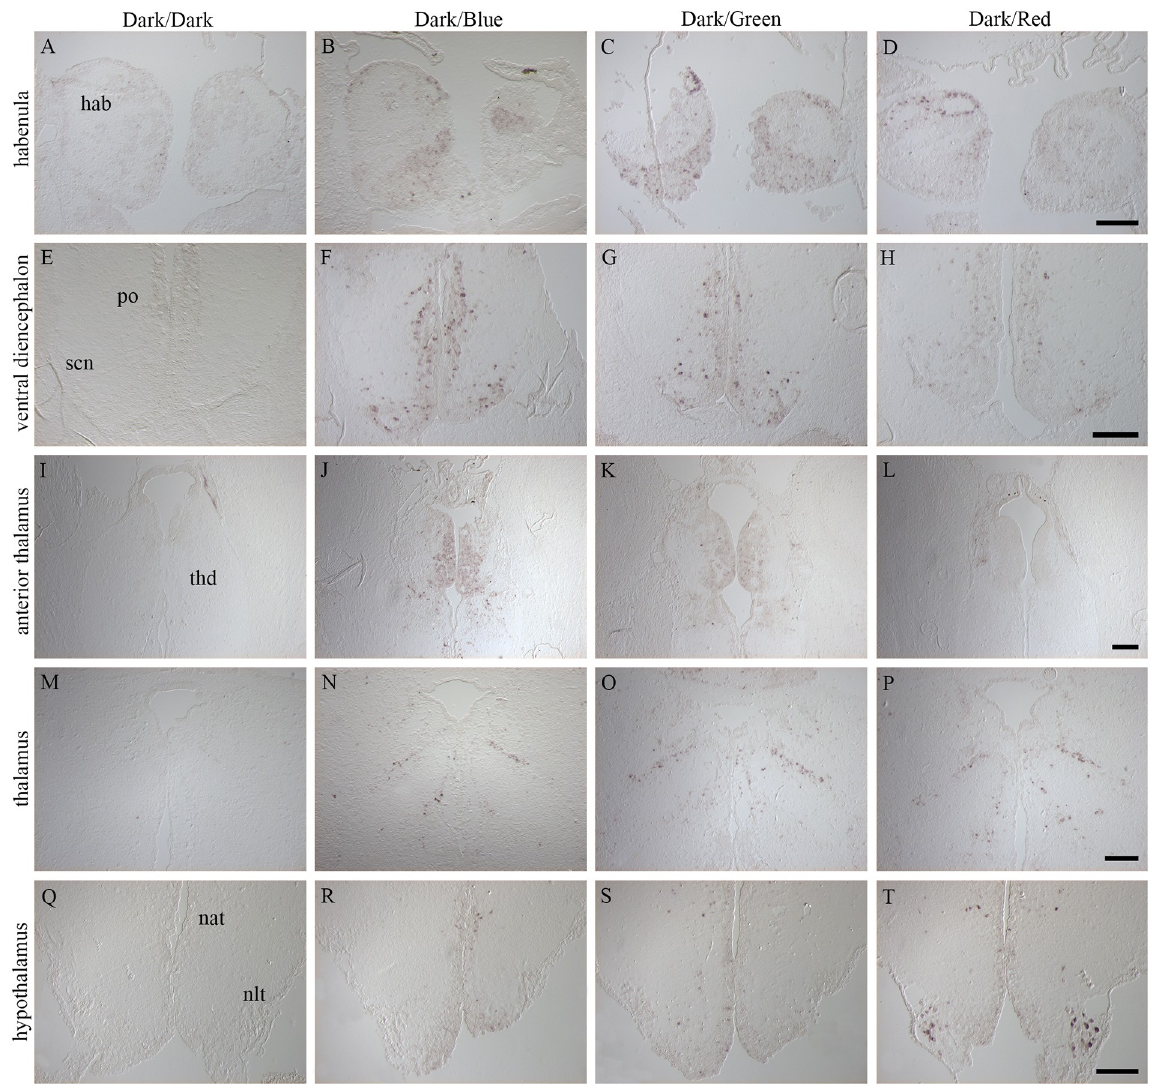
Fig 4. Comparison of c-fos positive signal in the brain of fish exposed to different narrow bandwidth light. Schematic drawings illustrate the plane of sections. A, E, I, M, Q, U: Control fish kept in darkness (Dark/Dark) showed no or little c-fos expression. B-D: A dorsal ring of c-fos positive cells was detected in the left habenula (hab) for all three spectra. F-H: In the ventral diencephalon, both the preoptic area (po) and superchiasmatic nucleus (scn) displayed c-fos expression. J-L: Expression of c-fos in the caudal habenula and dorsal thalamus (thd) for Blue (J) and Green (K), little expression in Red (L). N-P: Activated cells in caudal parts of the thalamus for all three spectra tested. R-T: In the hypothalamus, expression was detected in the anterior tuberal nucleus (nat) for the three spectra. In addition, a strong expression was detected in the lateral tuberal nucleus (nlt) for fish exposed to red light (T). Scale bars of 200 μ